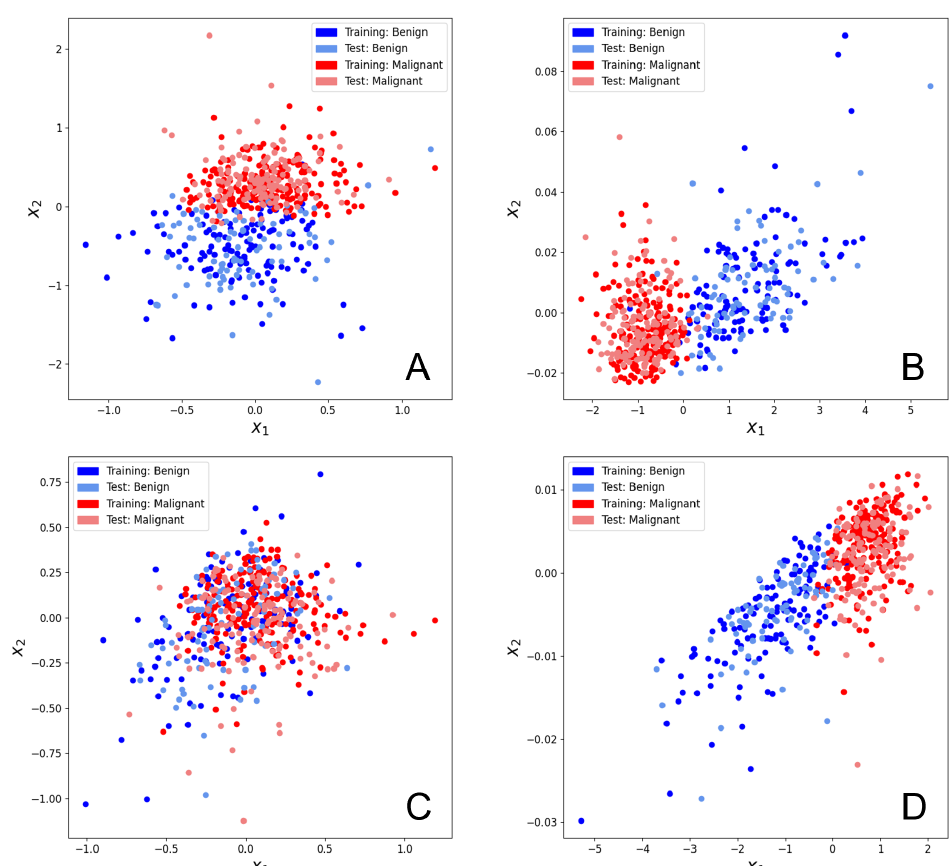
Figure 5. Scatter plots of the ( x 1 , x 2 ) values of the breast cancer dataset following feature reduction through PCA. Datapoints from both the training set and the test set are depicted. A random seed of ’1’ was used for the train-test split of this data. The PennyLane software package was used to optimize the parameters [40]. ( A ) Scatter plot of ( x 1 , x 2 ) values associated with 8 principal components after 0 training steps. These 8 principle components correspond to 16 trainable linear parameters. ( B ) Scatter plot of ( x 1 , x 2 ) values associated with 8 principal components after 1500 training steps. These 8 principle components correspond to 16 trainable linear parameters. ( C ) Scatter plot of ( x 1 , x 2 ) values associated with 4 principal components after 0 training steps. These 4 principle components correspond to 8 trainable linear parameters. ( D ) Scatter plot of ( x 1 , x 2 ) values associated with 4 principal components after 1500 training steps. These 4 principle components correspond to 8 trainable linear parameters.